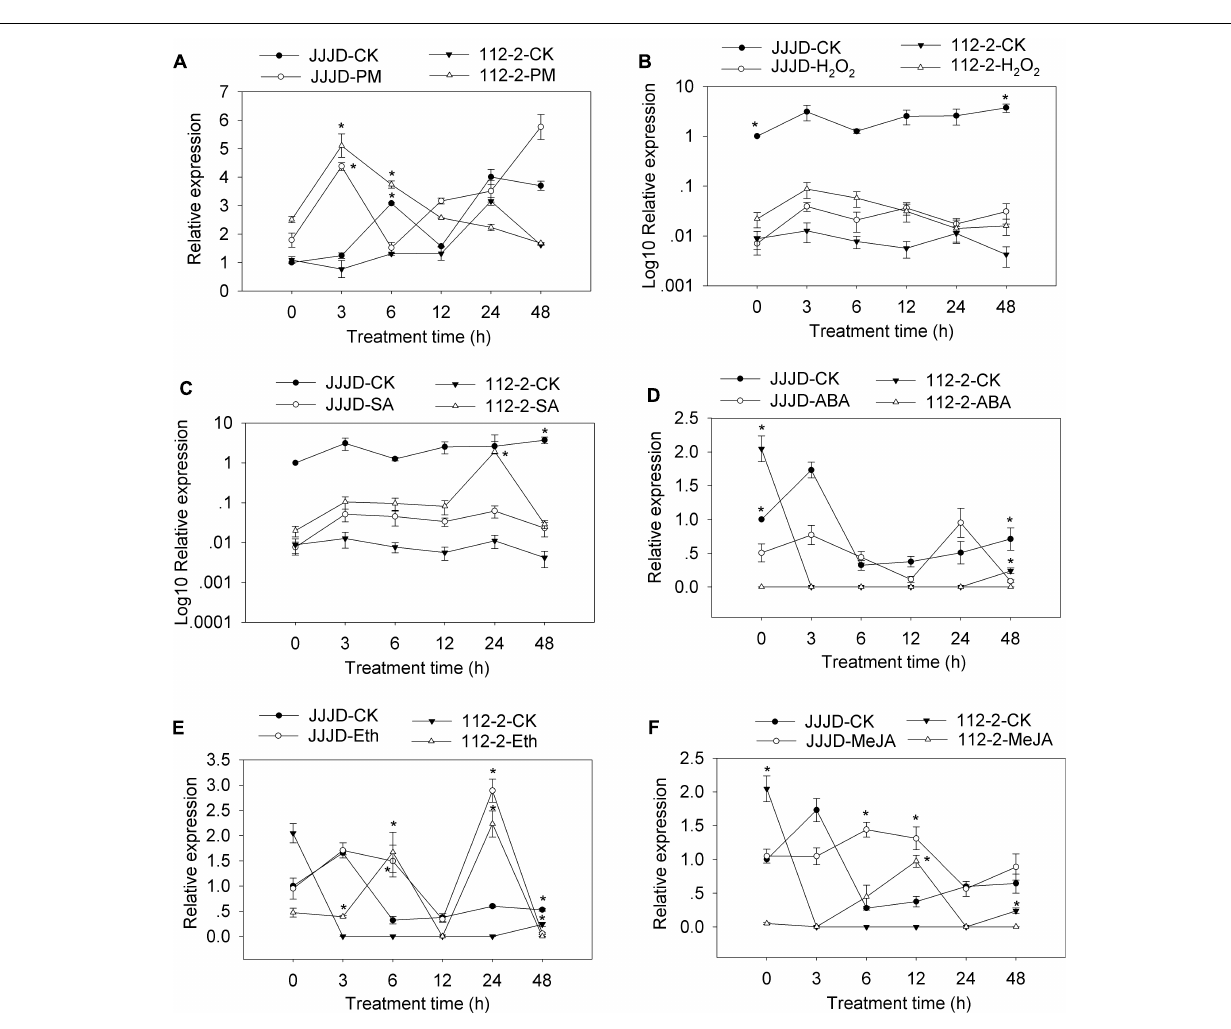
Frontiers in Plant Science |